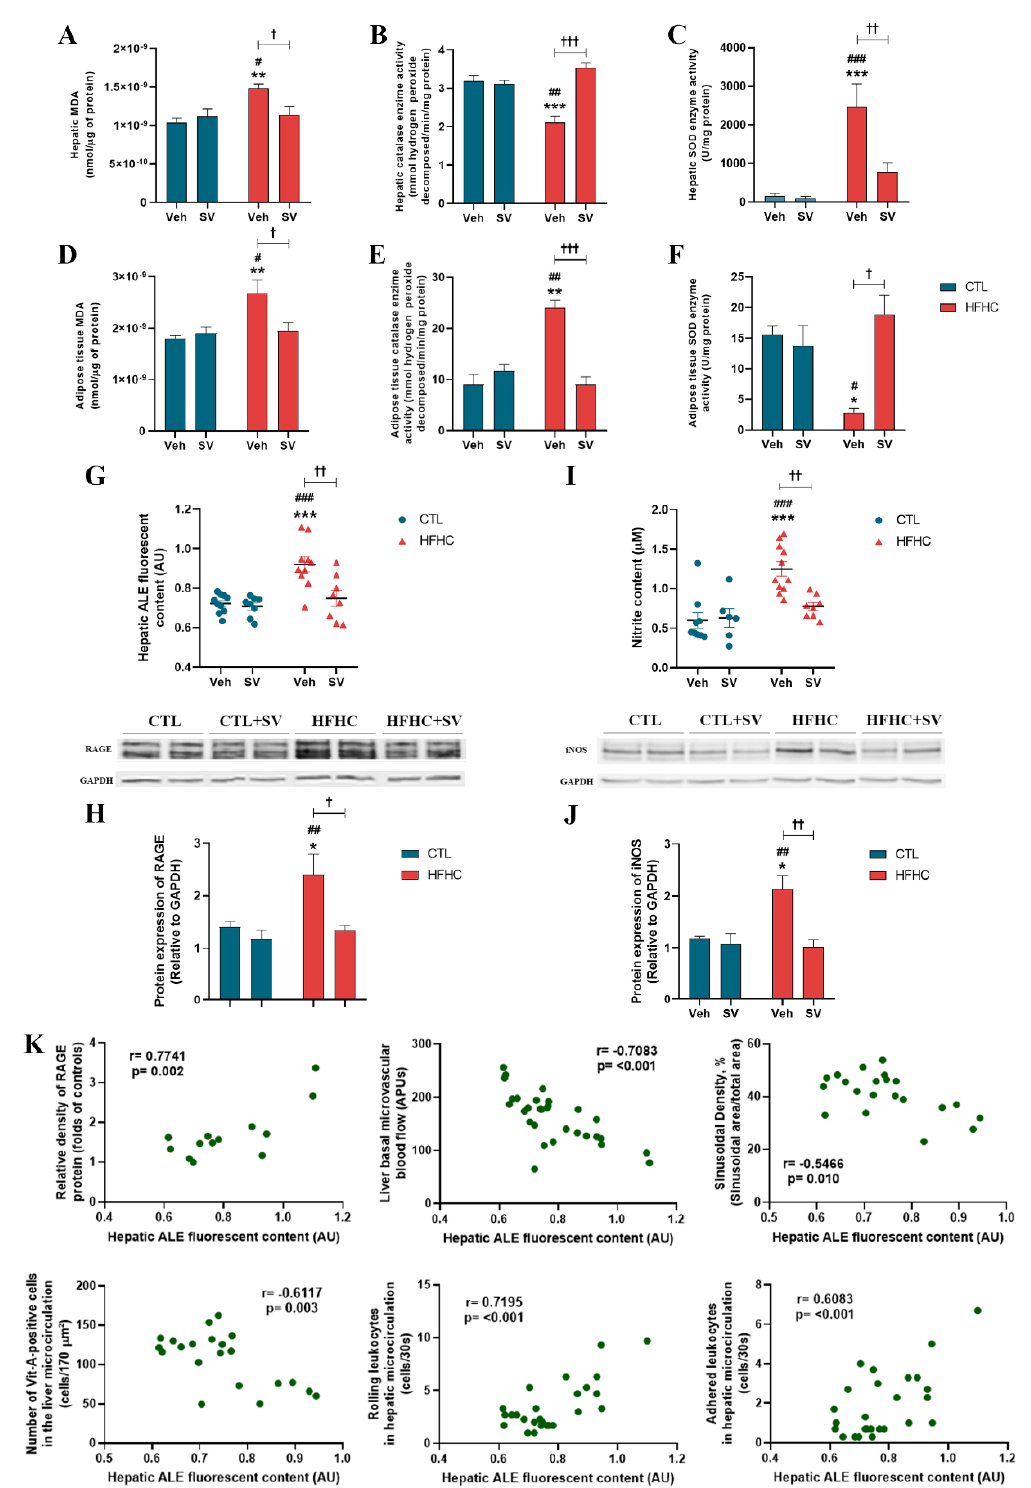
Figure 5. SV protects against NAFLD-induced oxidative damage and inflammation. Levels of malondialdehyde (MDA) indicating lipid peroxidation assessed by thiobarbituric acid reactive species (TBARs) ( A , D ), catalase enzyme activity ( B , E ) and superoxide dismutase enzyme activity ( C , F ) in the liver and epidydimal adipose tissues in mice fed with control diet (CTL+Veh), control diet plus SV (CTL+SV), HFHC diet (HFHC+Veh), or HFHC diet plus SV treatment (HFHC+SV). Hepatic advanced lipoxidation end product (ALE) deposition ( G ), receptors of advanced glycation end products (RAGE) protein expression in the liver ( H ), nitrite levels indicative of NO ( I ), and iNOS